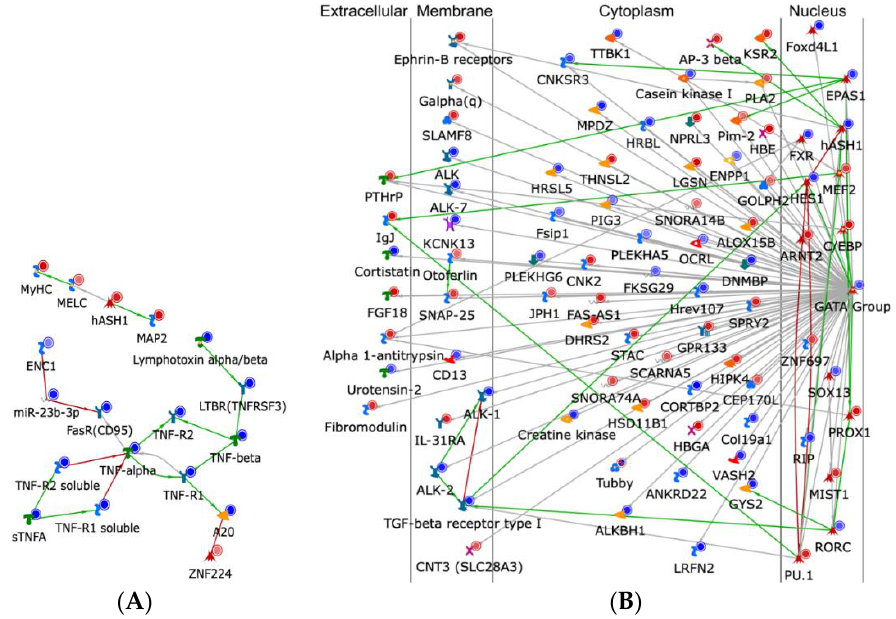
Figure 3. Example pathways regulated by IL-2 in CD 4+ naïve T cells ( A ) and CD 8+ naïve T cells ( B ). These figures were generated in the software Metacore. The meaning of these icons can be found in Metacore. Further explanation of the key legend is explained in Supplementary Material 6.